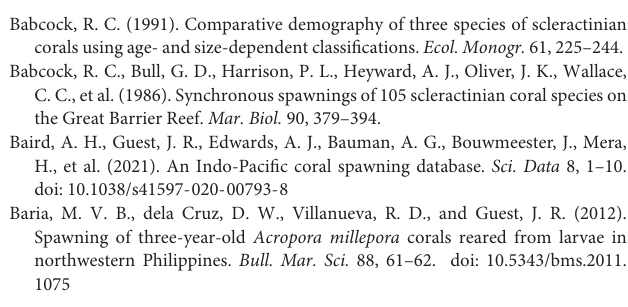
Supplementary Figure 1 | Sea Surface Temperature record obtained from NOAA. Supplementary Figure 2 | Environmental data in the experimental plots. ∗ = no data. Supplementary Table 1 | Summary of costs for larval enhancement and production of A. tenuis coral